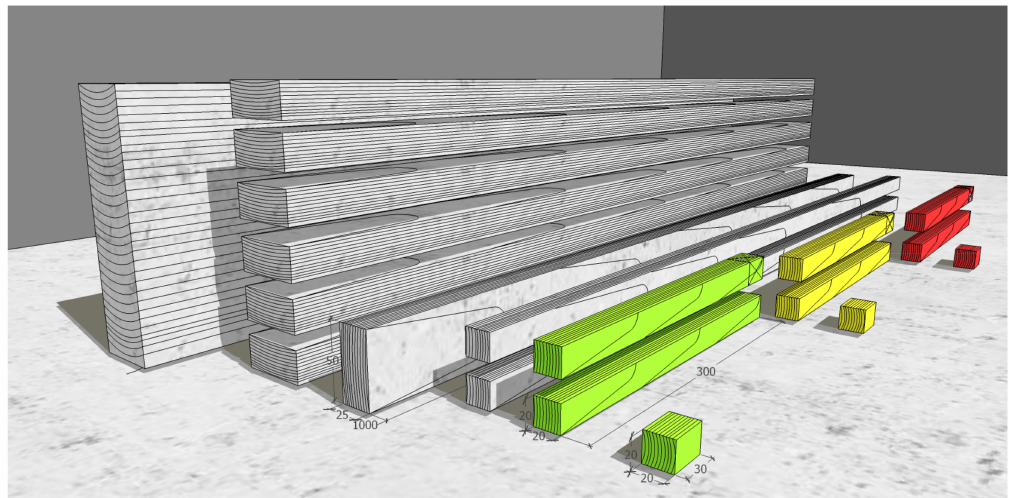
Figure 1. Cutting diagram for testing samples preparation. Green coloring = reference, with no treatment; yellow coloring = heat treatment at 165 ◦ C; red coloring = heat treatment at 210 ◦ C; upper set of samples = for the determination toughness; slanted hatching = for determination density, hardness, and moisture content; bottom set of samples = for the determination dynamic elasticity modulus, static elasticity modulus, and bending